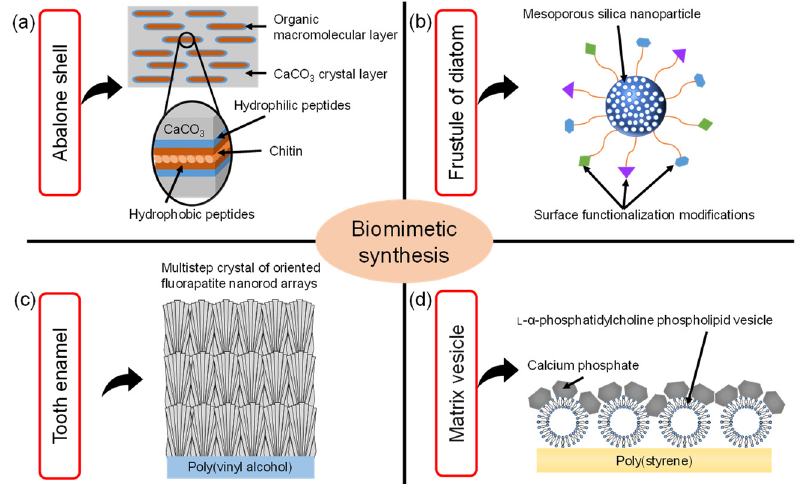
Figure 1. Illustration of the various biomimetic syntheses and their structures inspired by ( a ) nacre of the abalone shell, ( b ) frustule of diatom, ( c ) tooth enamel, ( d ) matrix vesicle shell (Reprinted with permission from Ref. [16]. ©2018, The Japan Society of Vacuum and Surface Science